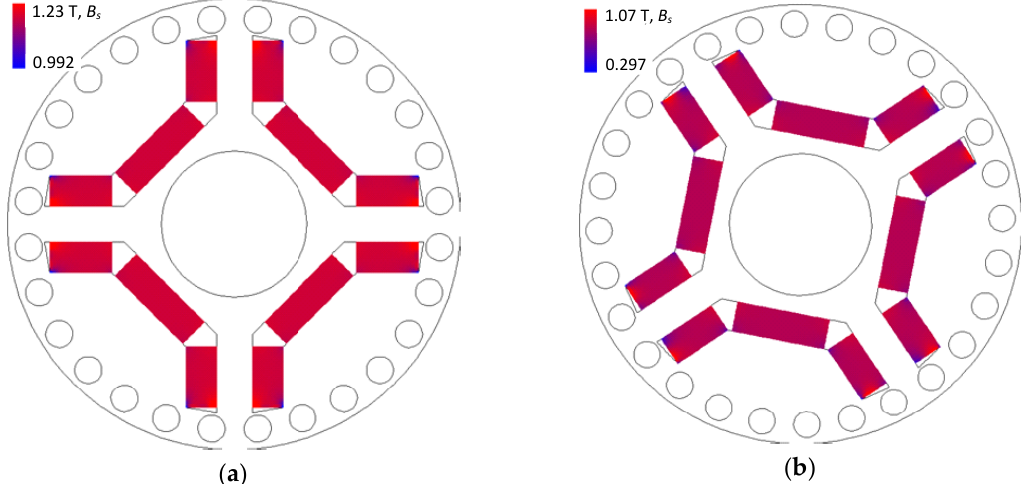
Figure 15. Distribution of magnetic flux density B s for T L = 19.5 Nm, τ i = 26°C , J i = 0.0082 kgm 2 : ( a ) before start-up, ( b ) after start-up at t = 0.6 s.